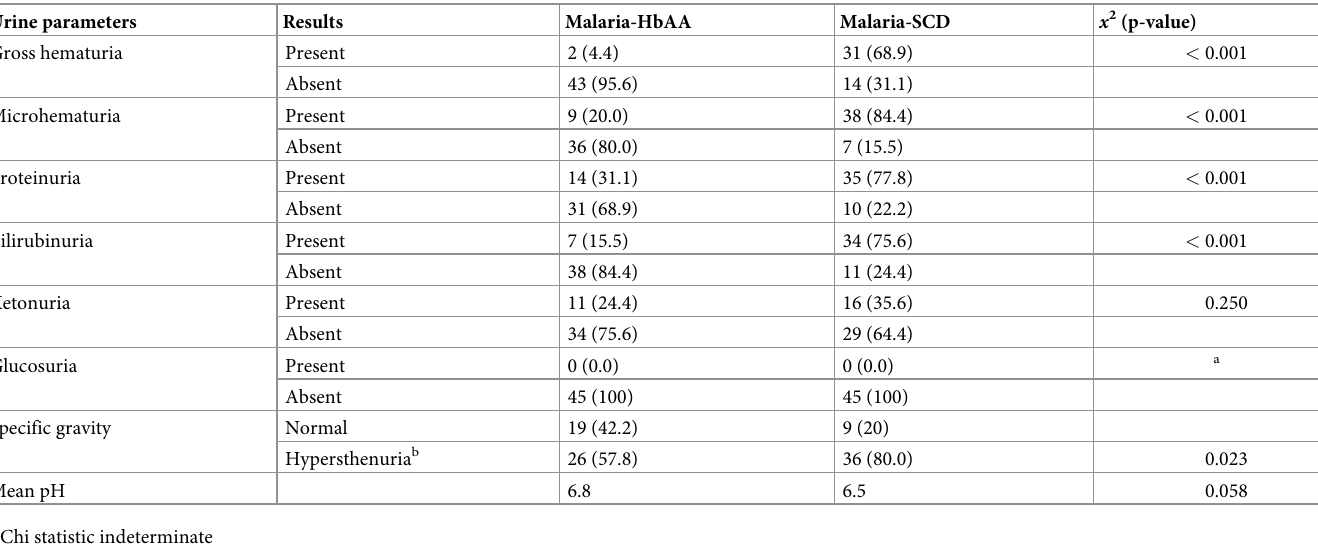
Table 4. Urinalysis findings of the